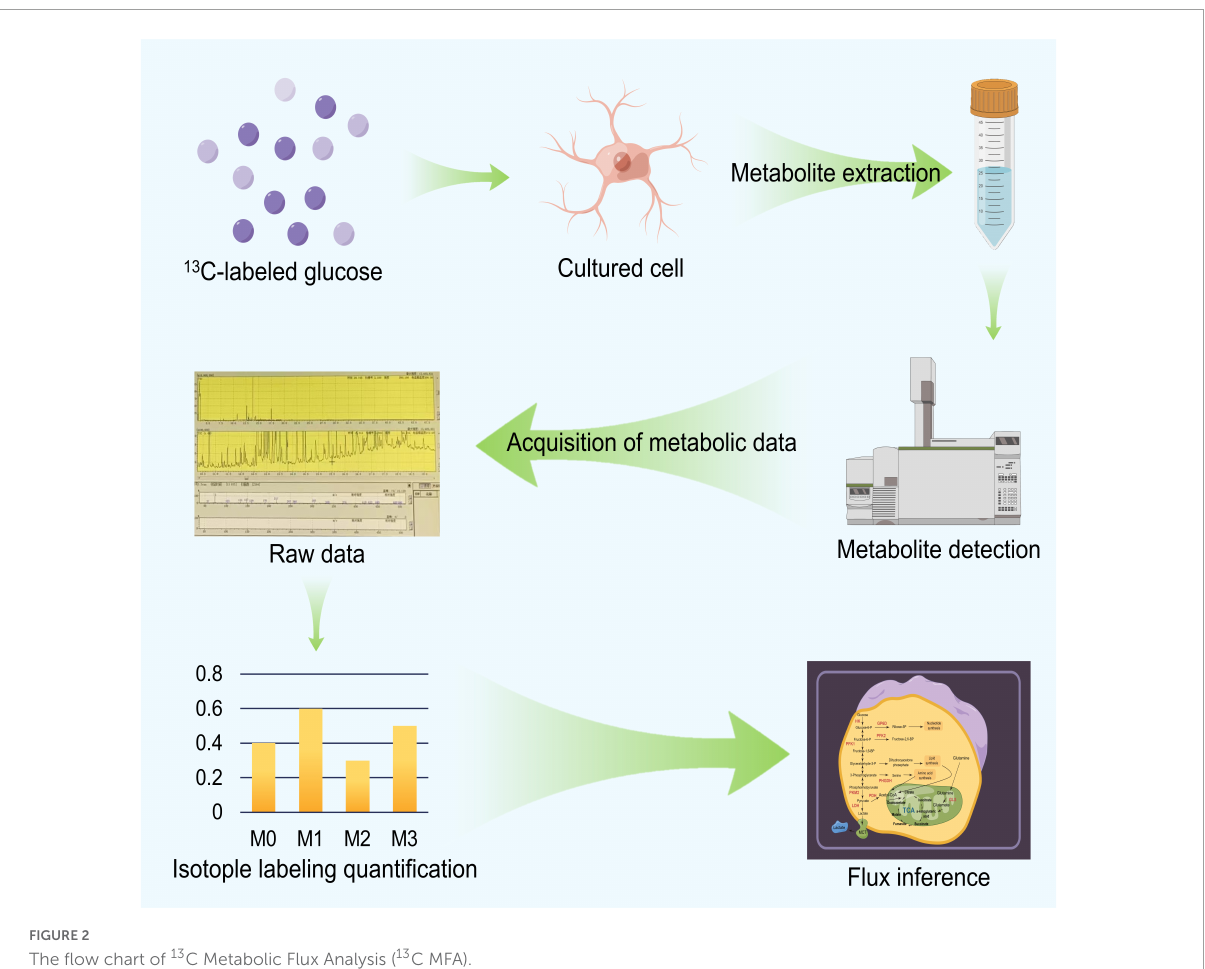
FIGURE2 The flow chart of 13 C Metabolic Flux Analysis ( 13 C MFA).